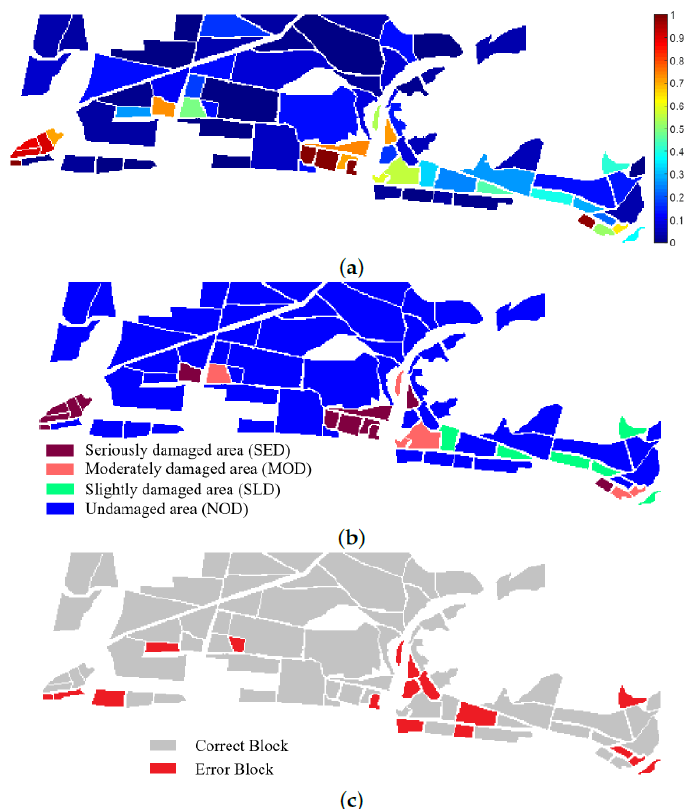
Figure 8. Results of the method proposed by Ji et al. on Ichinomaki city ( a ) Damage at the block level using their proposed method ( b ) Bloc classification into 4 classes using their method ( c ) Block-based error map; The image is modified from [24] with the authors’